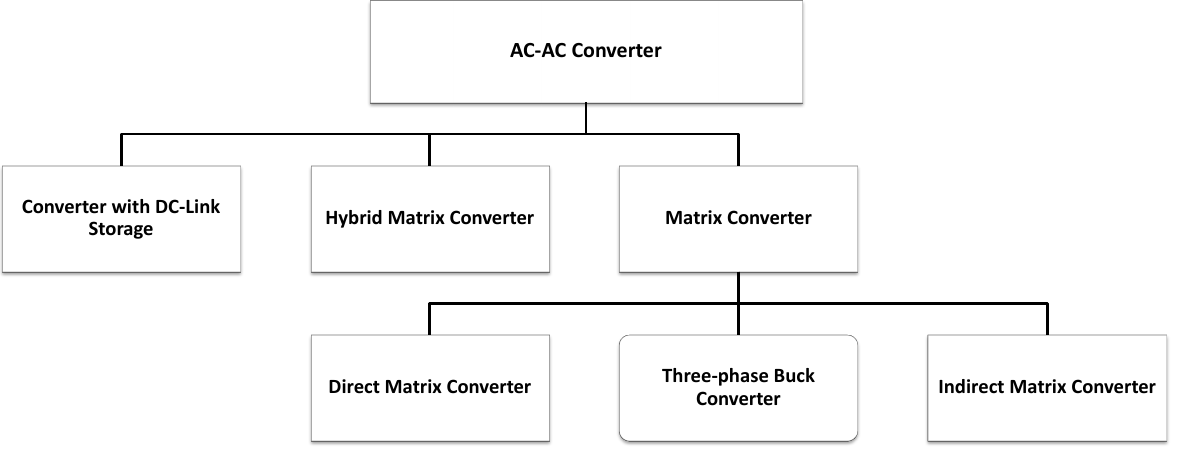
Figure 1. Landscape of three-phase AC-AC